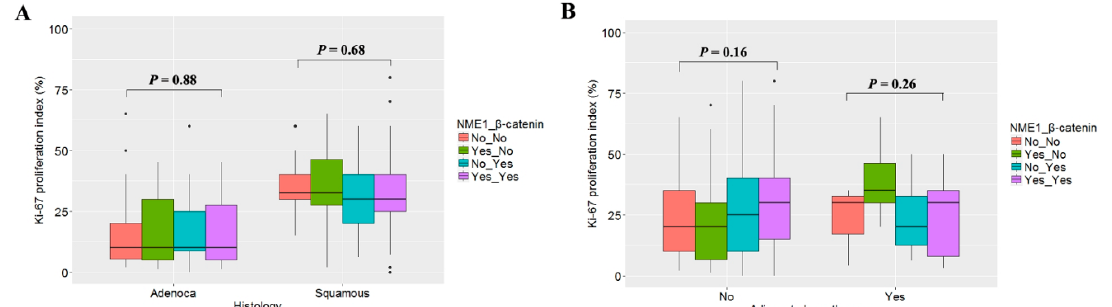
Figure 4. Ki-67 (MKI67) proliferation index according to altered expression of NME1 and β -catenin. Ki-67 proliferation was compared according to expression statuses of NME1 and β -catenin, stratified by histology ( A ) and adjuvant chemotherapy ( B ). “Adenoca” and “Squamous” represent adenocarcinoma and squamous cell carcinoma, respectively. “No” and “Yes” indicate the absence and presence of altered expression, respectively. P -values were calculated using one-way ANOVA.